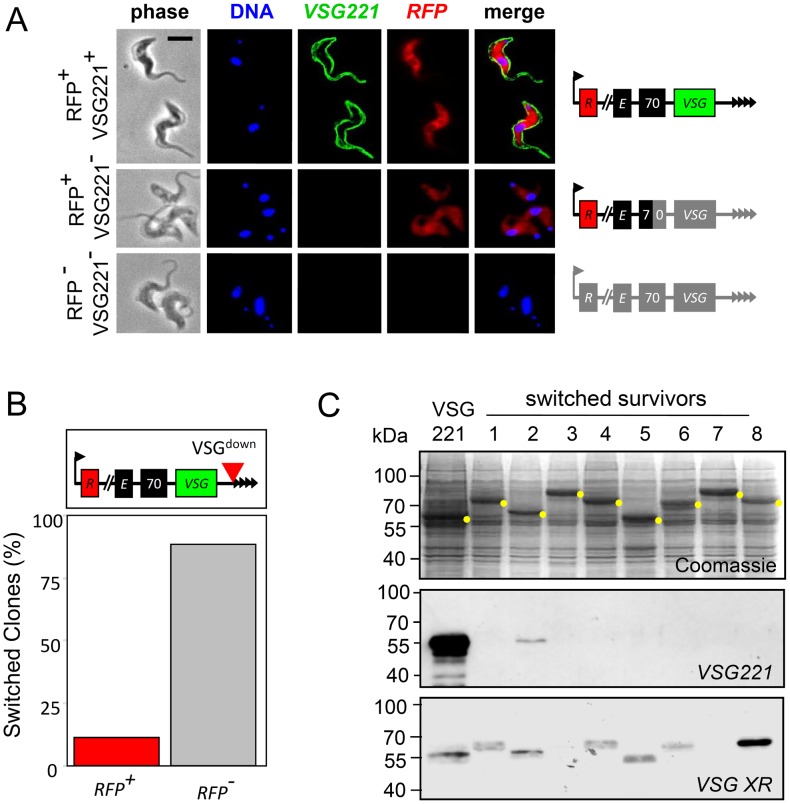
Telomere-adjacent breaks trigger BES loss or replacement.(A) Immunofluorescence analysis of VSGdown survivors. The schematic maps indicate the regions of the BES deleted/replaced in each case (grey) as determined using PCR assays (see FIG. 3B–C and FIG. S2). DNA was counter-stained with DAPI. Scale bar, 5 µm. (B) RFP status of switched survivors (n = 8) from the VSGdown strain, as determined by PCR assay (see FIG. S2C). Also see the schematic maps in Figure 2A and Figure S2A. (C) Examples of switched DSB-survivors. The Coomassie-stained gel indicates the abundant, clone-specific VSGs (yellow dots). The western blots were generated using a VSG221-specific or a VSG cross-reacting (VSG XR) antibody.